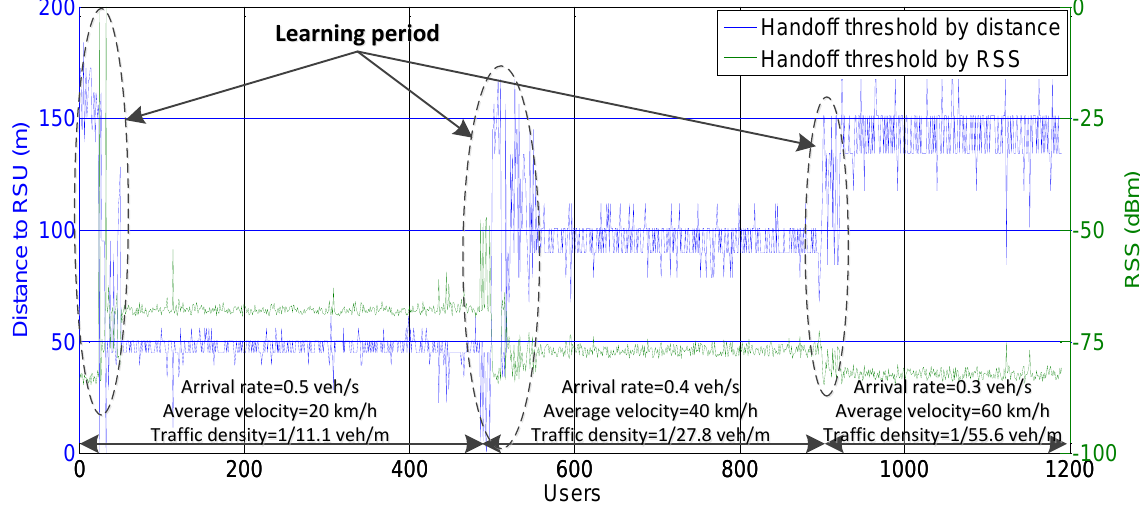
Figure 4. Vertical handoff threshold vs. different traffic conditions.